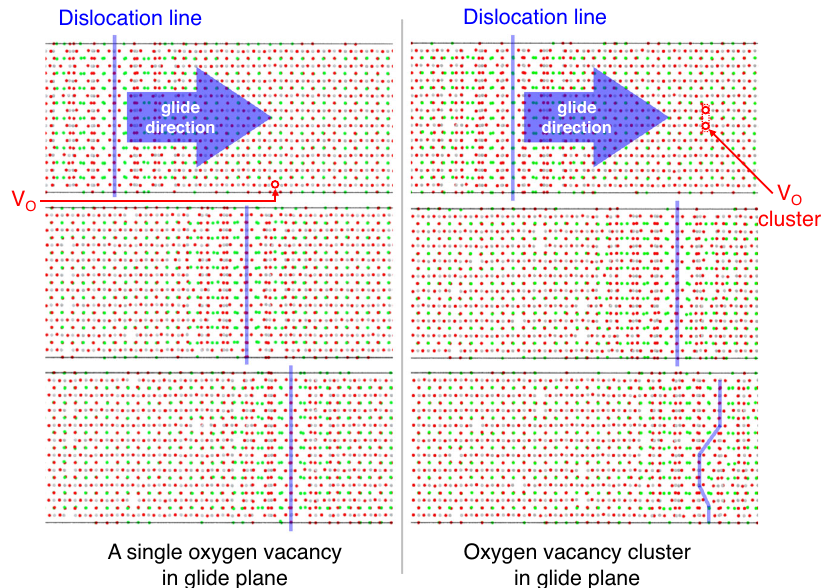
-- 11 Þ edge dislocation of vacancy (left fi gure) and a cluster of three oxygen vacancies (right fi gure). The simulation details are included in the supporting